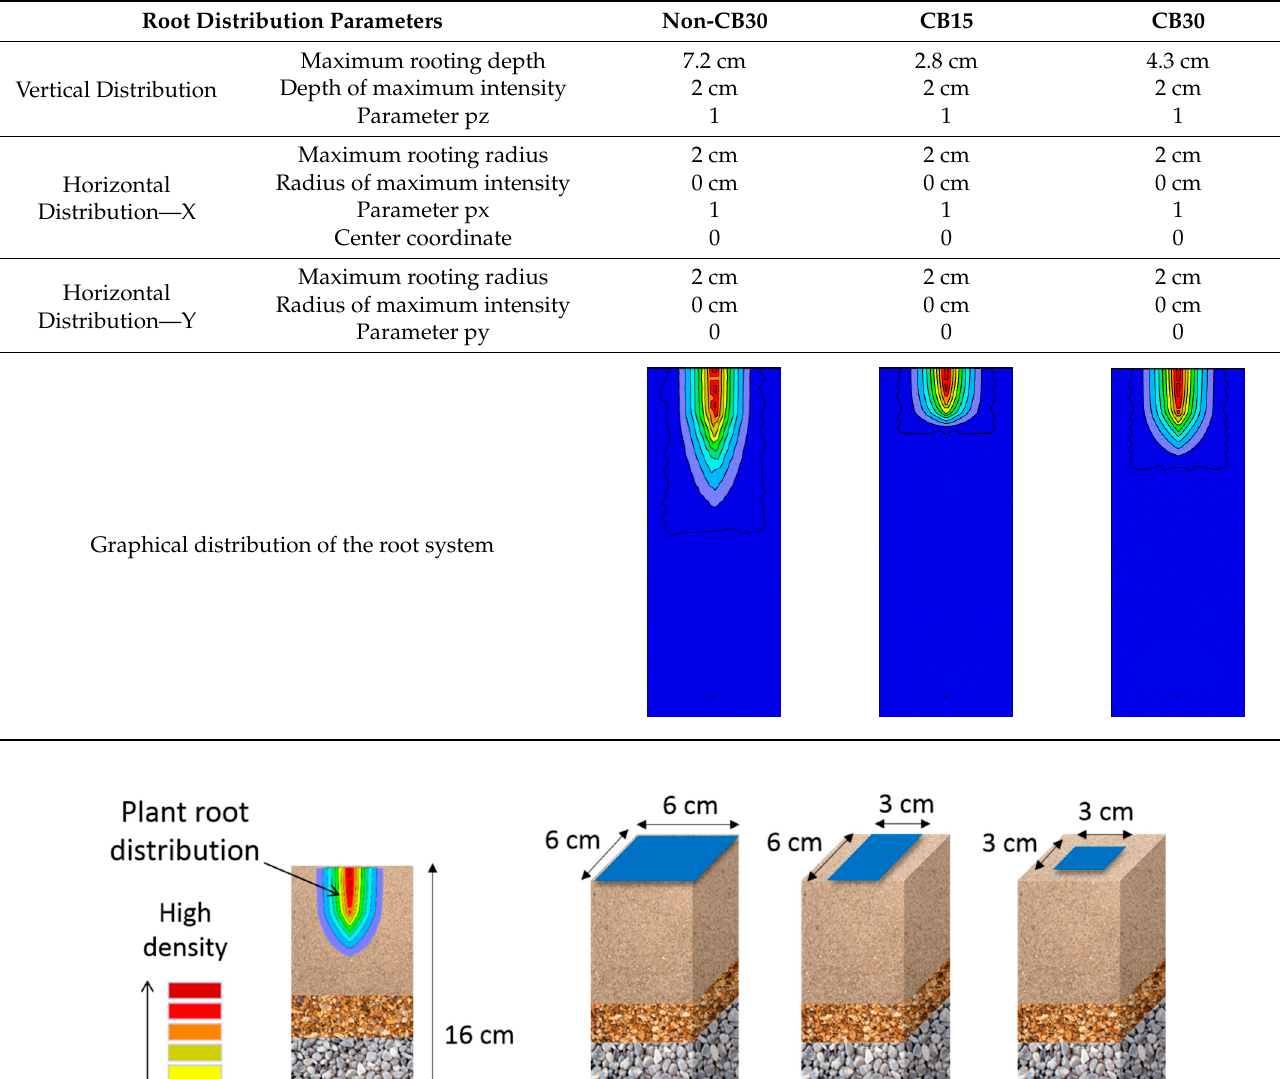
Table 3. Parameters for the Vrugt root distribution model [30] for different experimental scenarios (Non-CB30—A homo- geneous reference column and daily irrigation of 0.30 cm, CB15—A column with a CB and daily irrigation of 0.15 cm, and CB30—A column with a CB and daily irrigation of 0.30 cm) based on root data from Miyake et al. [20].